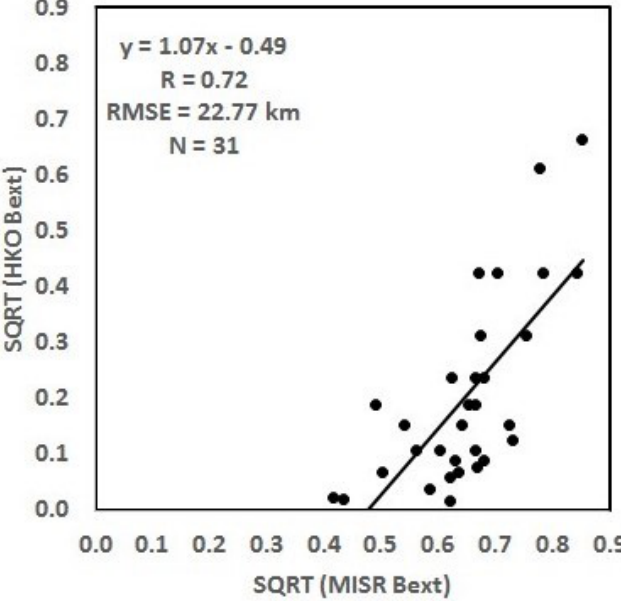
Figure 15. Correlation between Square root of MISR B ext and Square root of ground visibility at HKO using Equation (7) for 2005 to 2008. Black solid line is the resultant regression line and N is the total number of